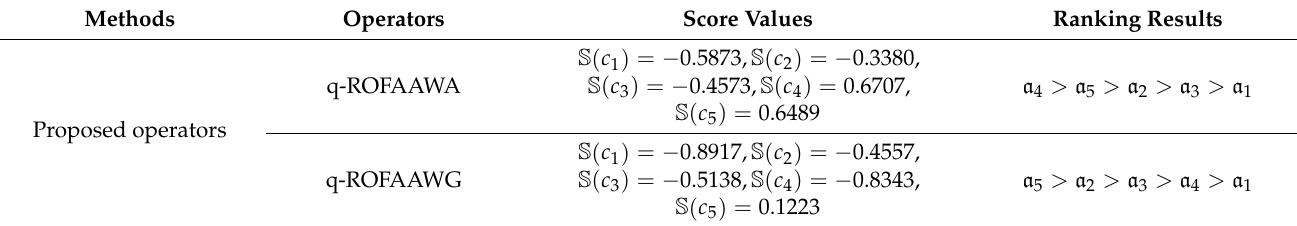
Table 10. Comparative analysis with existing